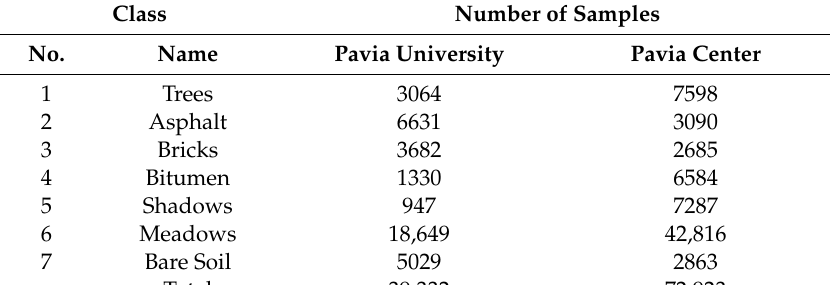
Table 3. Land cover classes and the number of samples for Shanghai–Hangzhou.